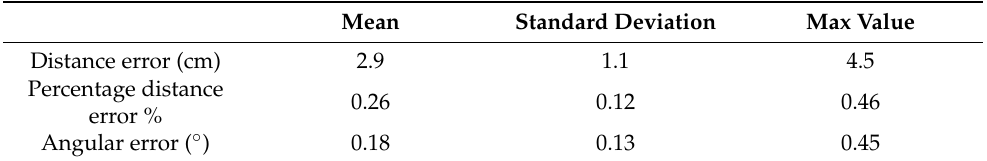
Table 2. Mean, standard deviation, and maximum values of distance error from point n. 1, percentage distance error from point n. 1, and angular error from the y -axis (grid